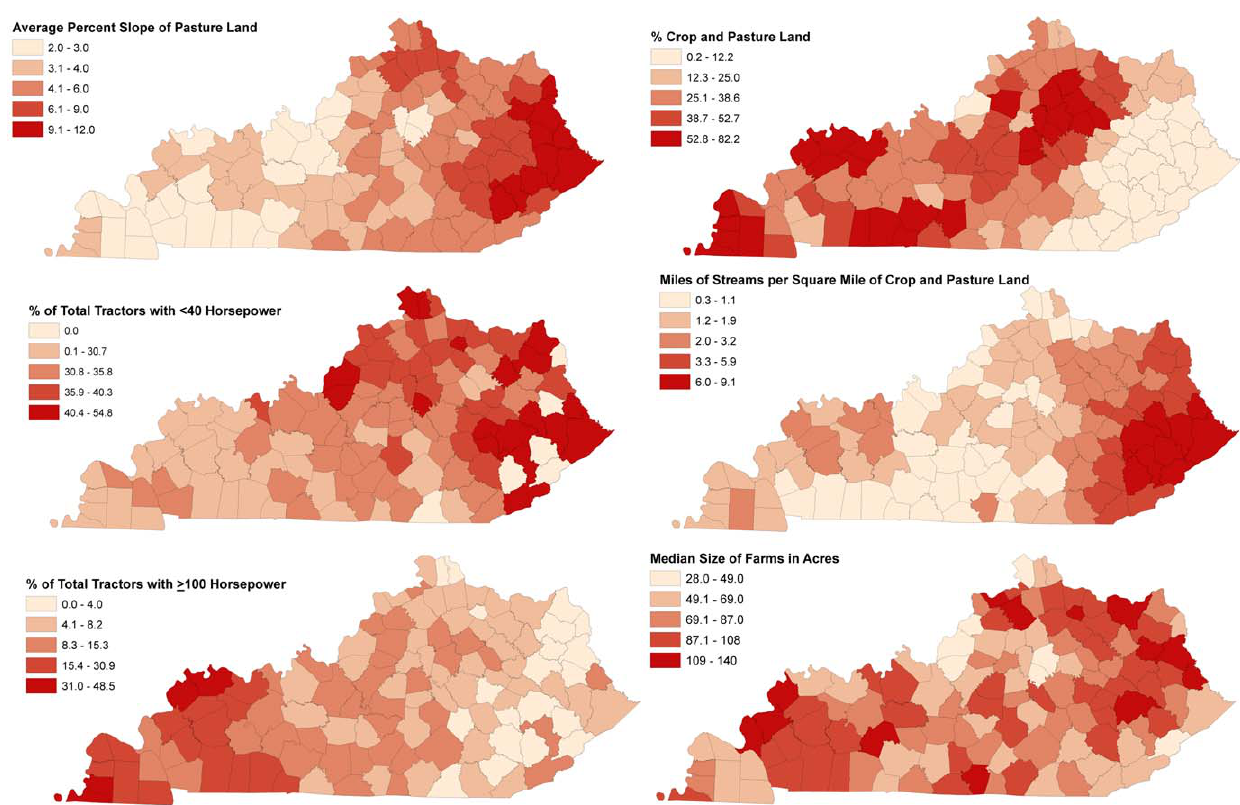
Figure 4. County level tractor characteristics and physiographic characteristics in Kentucky.